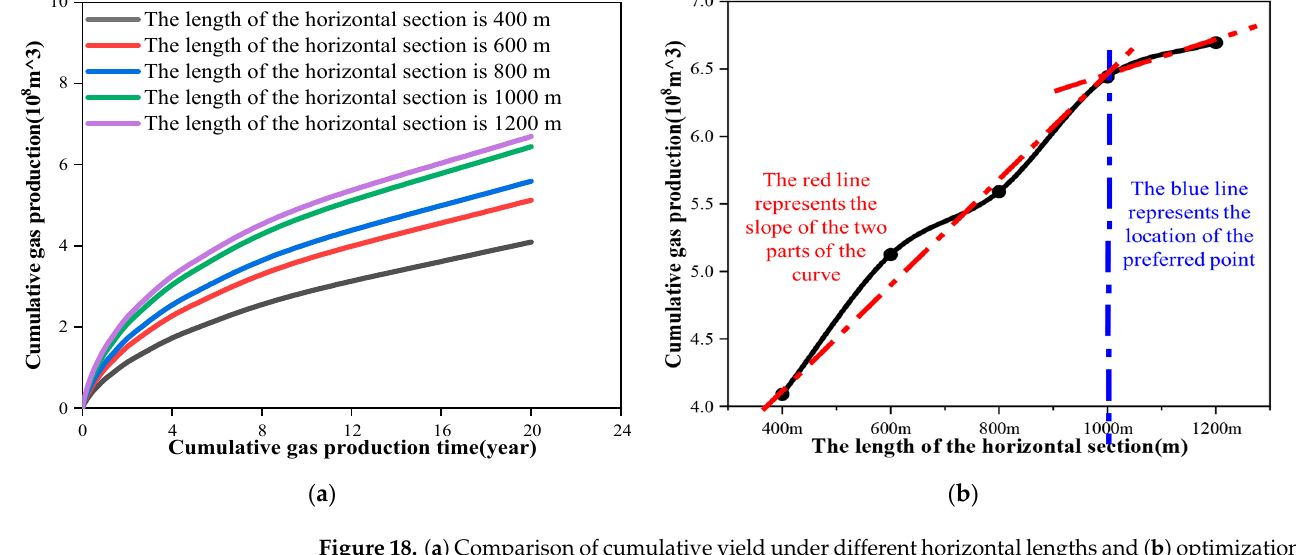
levels is shown in Figure 18.